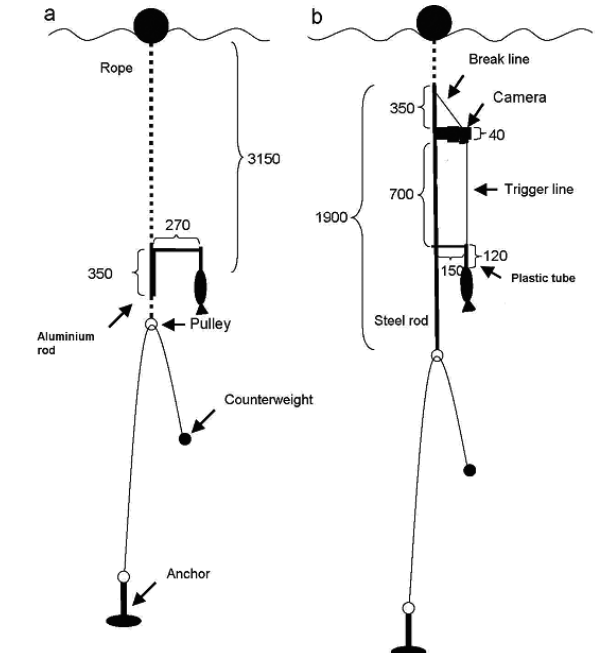
Fig. 3. Experimental setup with (a) a baited buoy and (b) a baited buoy with camera